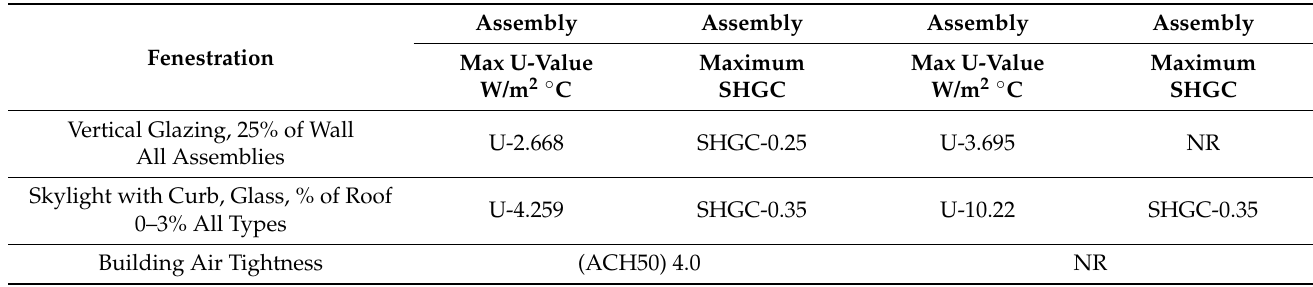
Table A2. Fenestration for zone 1, 2 and 3 [11].